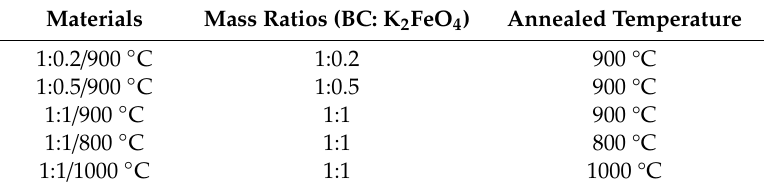
Table 1. The information about the graphitic biomass